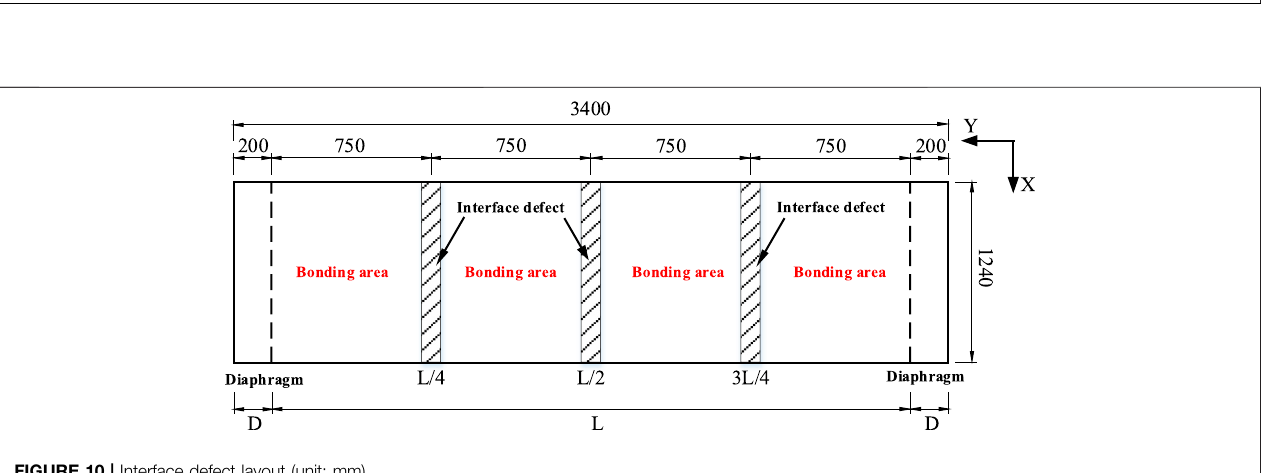
FIGURE 9 | Schematic diagram of local wheel load. (A) Vehicle load. (B) Wheel load (load unit: kN, size unit: mm).